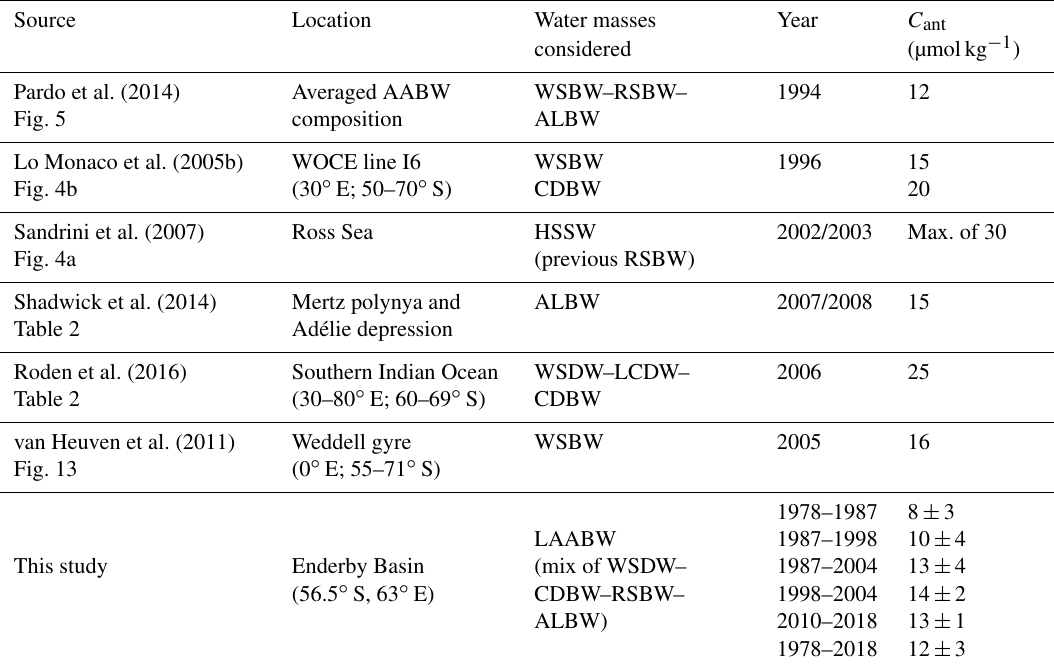
Table 3. Compilation of C ant sequestration investigations in the AABW ( γ n ≥ 28 . 25kgm − 3 ) using the TrOCA method. The C ant estimation of Pardo et al. (2014) is calculated using theoretical AABW mean composition (with 3% of ALBW) and the carbon data from the GLODAPv1 and CARINA databases. Sandrini et al. (2007) values have been measured at the bottom of the Ross Sea and correspond to recently sinking high-salinity shelf water (HSSW). The mean values published by Roden et al. (2016) for the AABW present WSDW characteristics but can be a mix of CDBW and